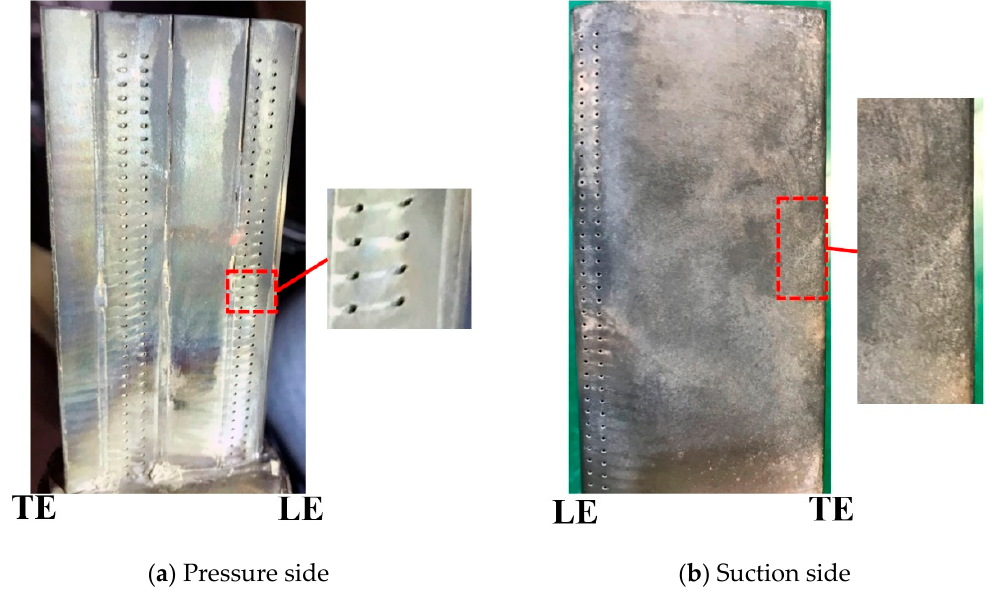
Figure 12. Photos of the sand deposition on the ( a ) pressure and ( b ) suction sides of the test model at the mainstream temperature of 1272 K.